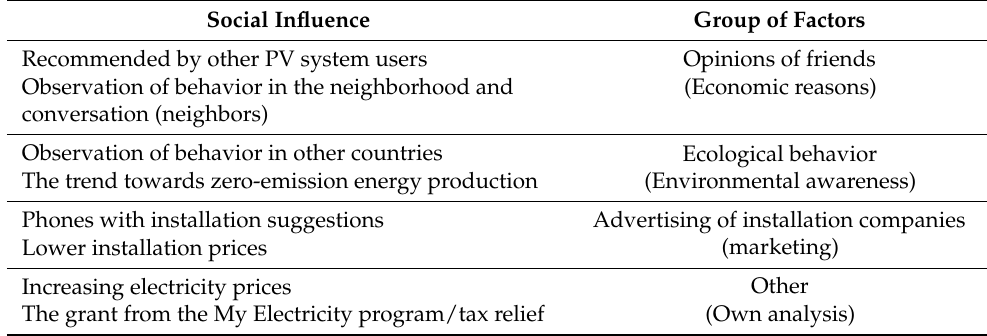
Table 4. Social impact on making decisions about micro-installations ( n = 12).